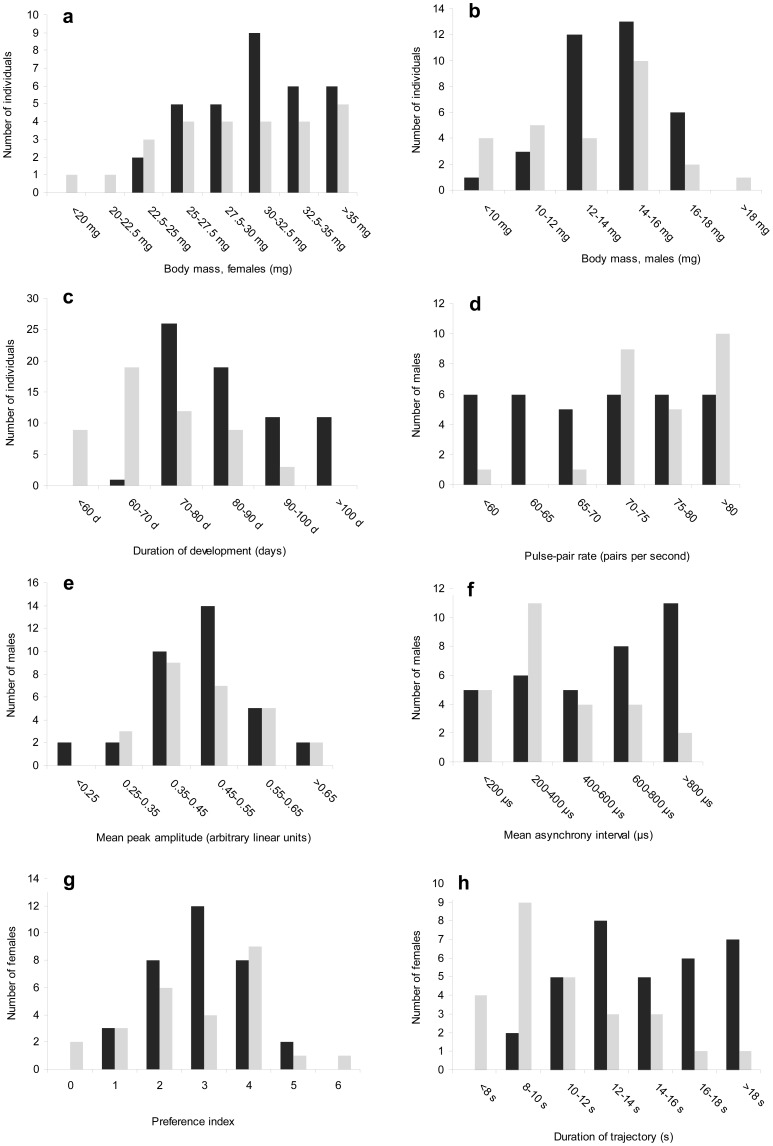
Phenotypic variation of developmental and sexual traits observed in both broods sampled for genotype analysis.In each graph, the dark and light vertical bars represent brood Xt7 and brood Xt19, respectively. CV7 and CV19 indicate the coefficients of variation for brood Xt7 and brood Xt19, respectively. t-test (2-tailed) as applied to within-brood comparisons where data satisfied the requirements of normality and equality of variance; H0: averageXt7 = averageXt19. Mann-Whitney test (2-tailed) as applied to within-brood comparisons where data did not satisfy the requirements of normality and equality of variance; H0: averageXt7 = averageXt19. (A) Body mass at adult eclosion, females. (B) Body mass at adult eclosion, males. (C) Duration of development of tested individuals. (D) Pulse-pair rate of male song. (E) Mean peak amplitude of male song. (F) Mean asynchrony interval duration of male song. (G) Female preference index. (H) Duration of female trajectory from release point to arrival at one of 2 stimuli (broadcasting loudspeakers).